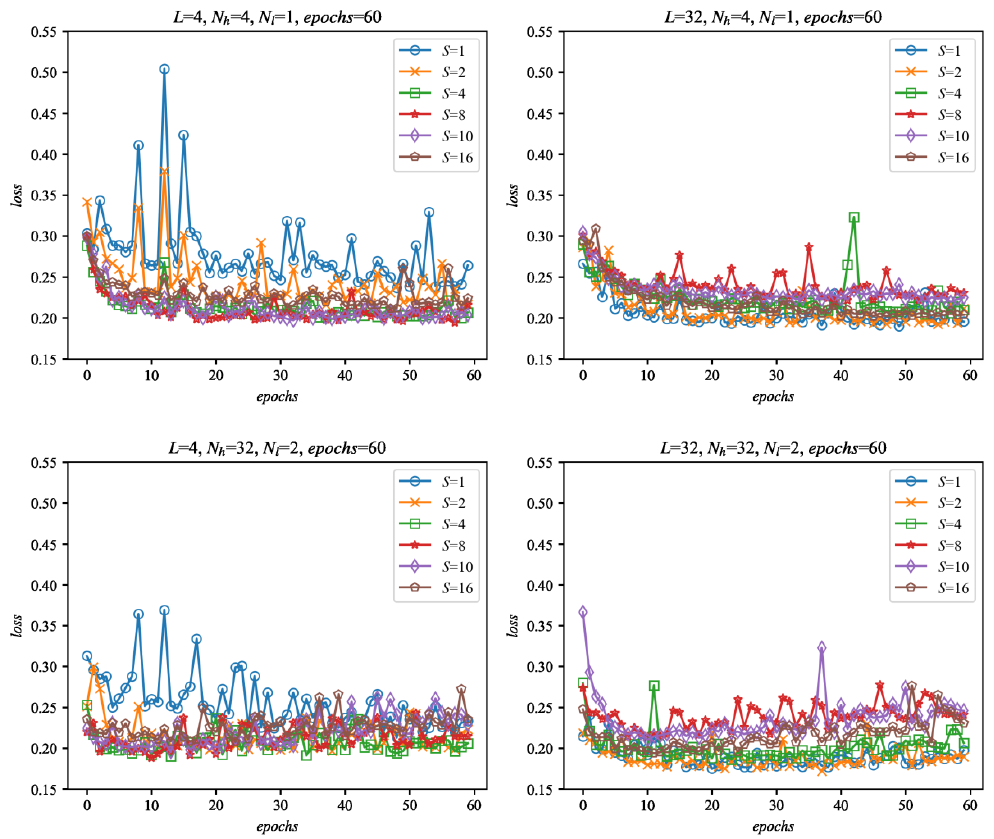
Figure 9. Selected evaluation results of the networks during training as a function of the number of epochs. Evaluation was performed with the set of 29 evaluation signals, separate from the training data, for the selected configurations of networks: N l = {1, 2}, N h = {4, 32} and input data size: L = {4, 32} and sampling: S = {1, 2, 4, 8, 10, 16}. The loss is calculated as an average evaluation loss of all of the evaluation signals.